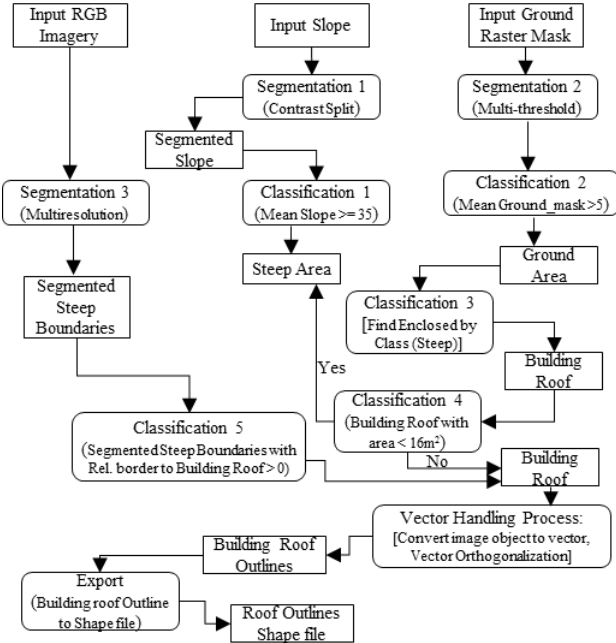
Figure 1. Workflow diagram for extraction of building roofs The LiDAR-derived data (slope raster and ground raster mask) and aerial imagery were used as inputs in eCognition Developer 9.1. The first process in the rule-sets requires the slope raster to be segmented using the contrast split segmentation algorithm (Segmentation 1) to create a steep boundary around